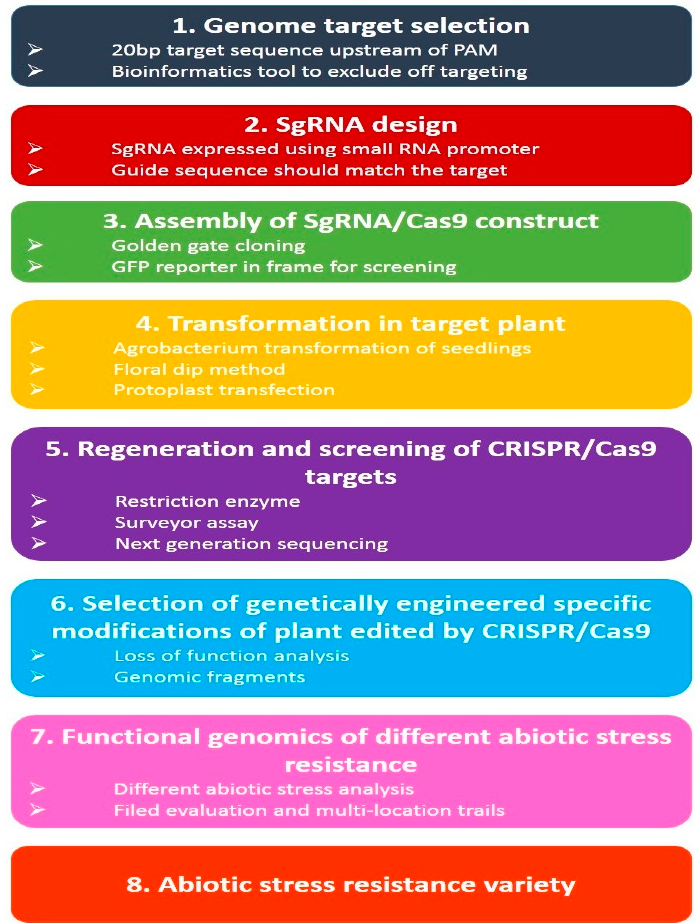
Figure 7. A model of CRISPR/Cas9 based genome engineering to develop transgenic plants or abiotic stress tolerance cultivars.